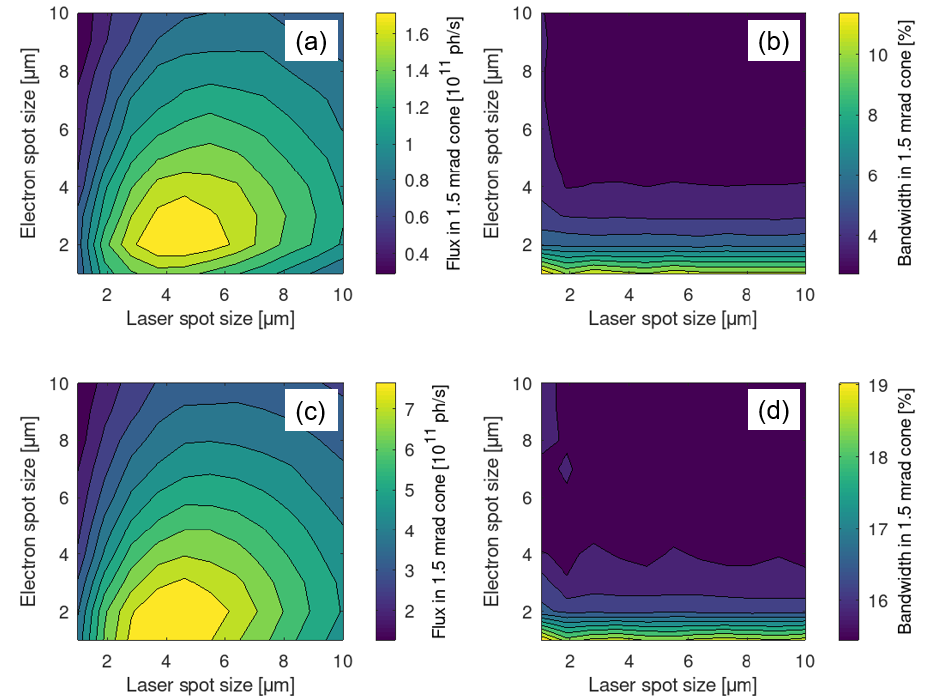
Figure 9. Parametric scans of flux and bandwidth in a 1.5mrad cone. The laser and electron spot sizes were varied to determine the maximum flux in a 1.5mrad cone. ( a ) Scan of flux in a 1.5mrad cone at a beam energy of 100MeV. ( b ) Scan of bandwidth in a 1.5mrad cone at a beam energy of 100MeV. ( c ) Scan of flux in a 1.5mrad cone at a beam energy of 300MeV. ( d ) Scan of bandwidth in a 1.5mrad cone at a beam energy of